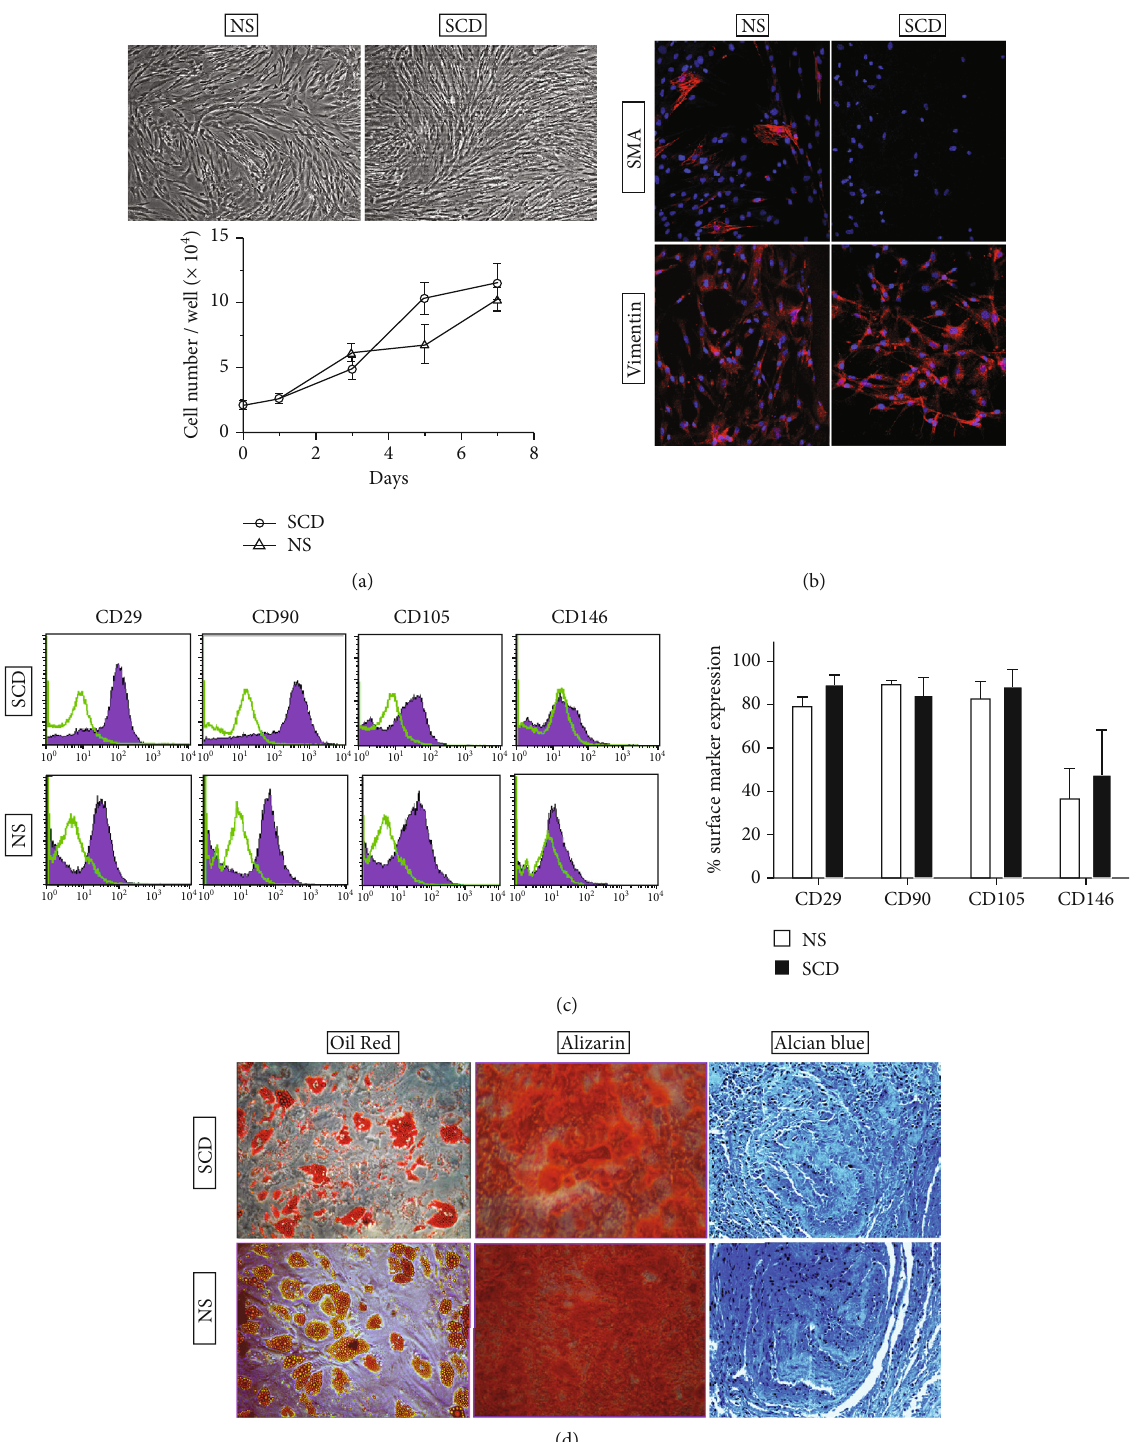
Figure 4: BM-MSCs from SCD and NS patients display similar immunophenotypes and in vitro characteristics. (a) Morphology and cell growth expansion of BM-MSC. Cells were subcultured and counted on the indicated day for 7 days. (b) Immunocytochemistry detection shows α -SMA and vimentin-positive BM-MSCs. Nuclei were stained with Hoechst dye (blue). (c) Flow cytometry histograms for positive MSC speci fi c markers (purple line) and the respective isotype-matched control (green line) are shown. (d) Multipotential BM-MSCs from representative SCD and NS patients were di ff erentiated toward adipogenic, osteoblastic, and chondrogenic lineages. Accumulation of intracellular lipid vacuoles shown by Oil Red O staining (left), calcium-rich extracellular matrix as evidenced by Alizarin red S (middle), and static micromass cell culture stained with Alcian blue (right). Statistical analyses (Student t -test) were performed between values, and the data are reported as the mean and standard deviation. Scale bar = 50 μ